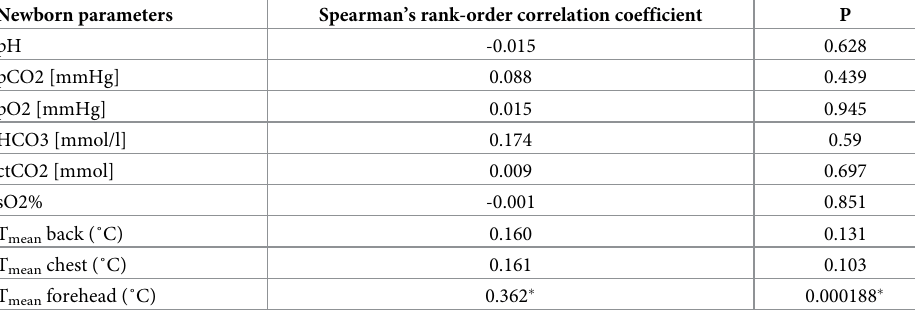
Table 3. Spearman’s rank-order correlation of the mode of delivery (vaginal delivery vs. cesarean section) with selected newborn